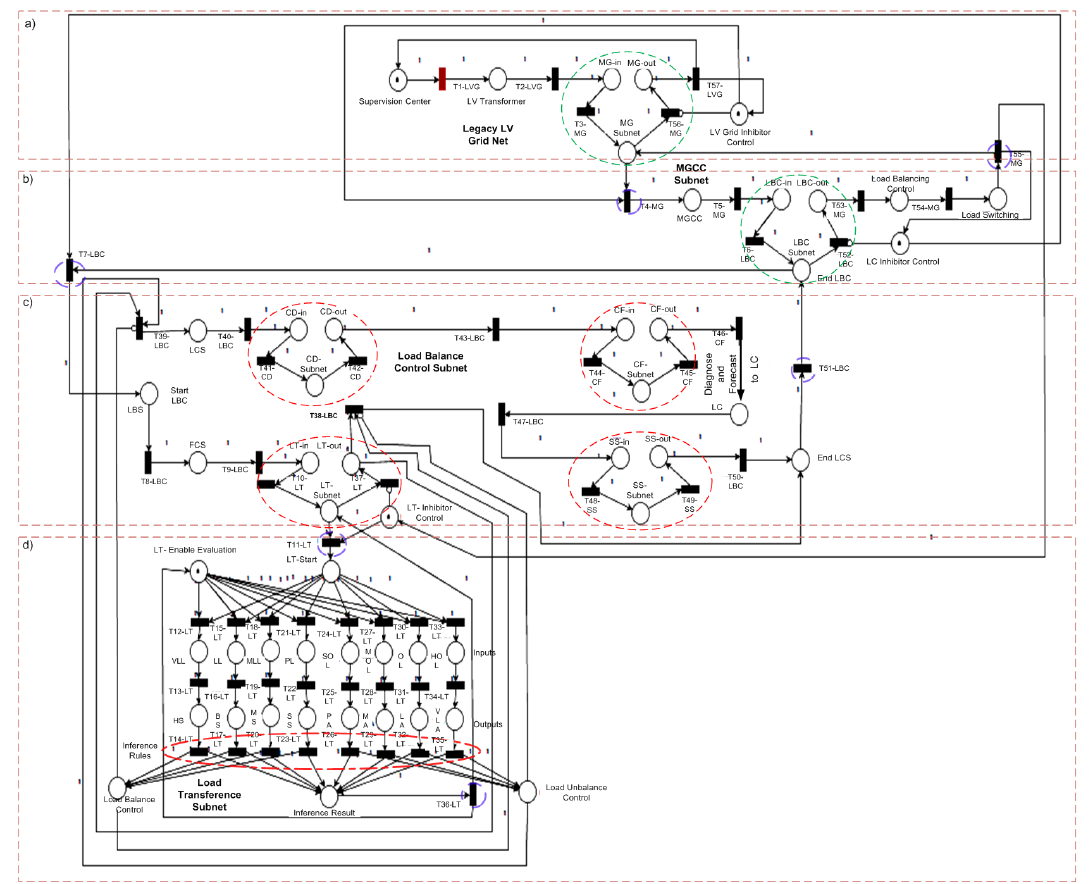
Figure 7. HPN System design: ( a ) Legacy LV Grid net; ( b ) MGCC subnet; ( c ) LBC subnet; ( d ) LT